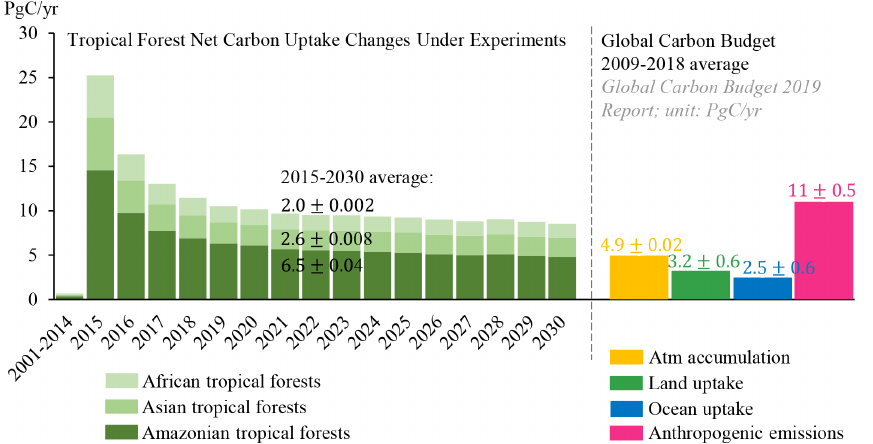
Figure 4. Capabilities of Amazonian, African, and Asian tropical forests to offset annual atmospheric carbon accumulation.